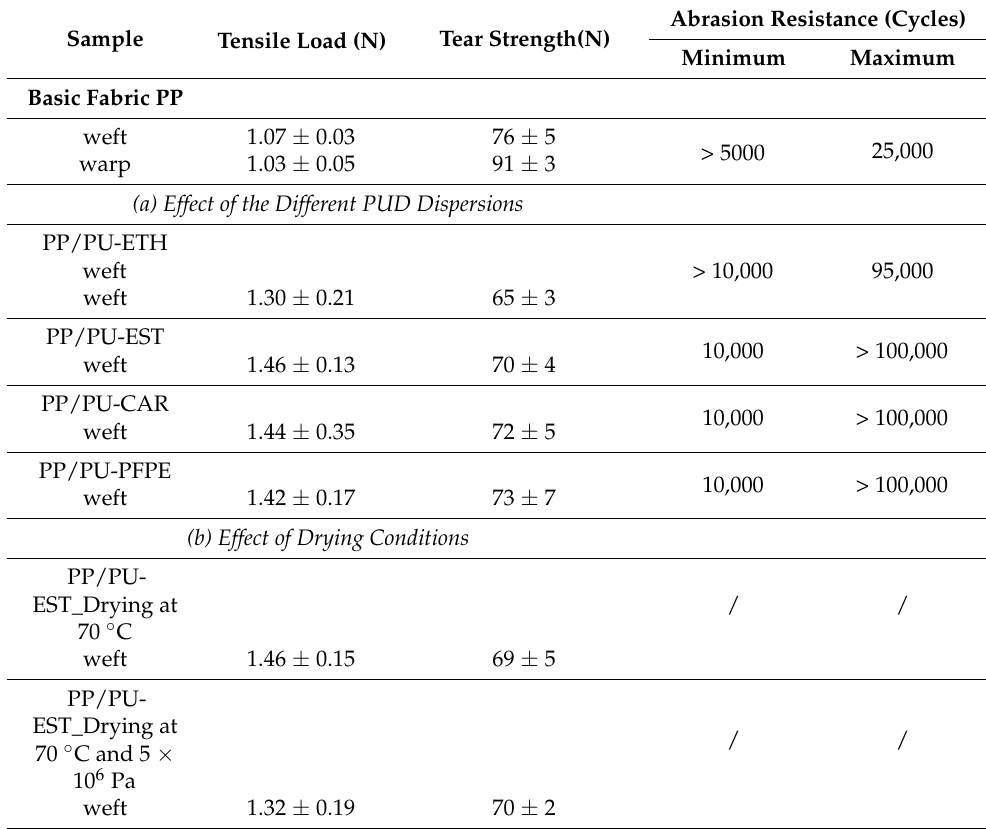
Figure 6. Load-displacement curves of representative samples for each tested material by tensile testing: ( a ) the basic PP fabric in warp and weft directions, ( b ) impregnated samples with different polyurethane dispersions in weft direction. Table 2. Mechanical performance of investigated